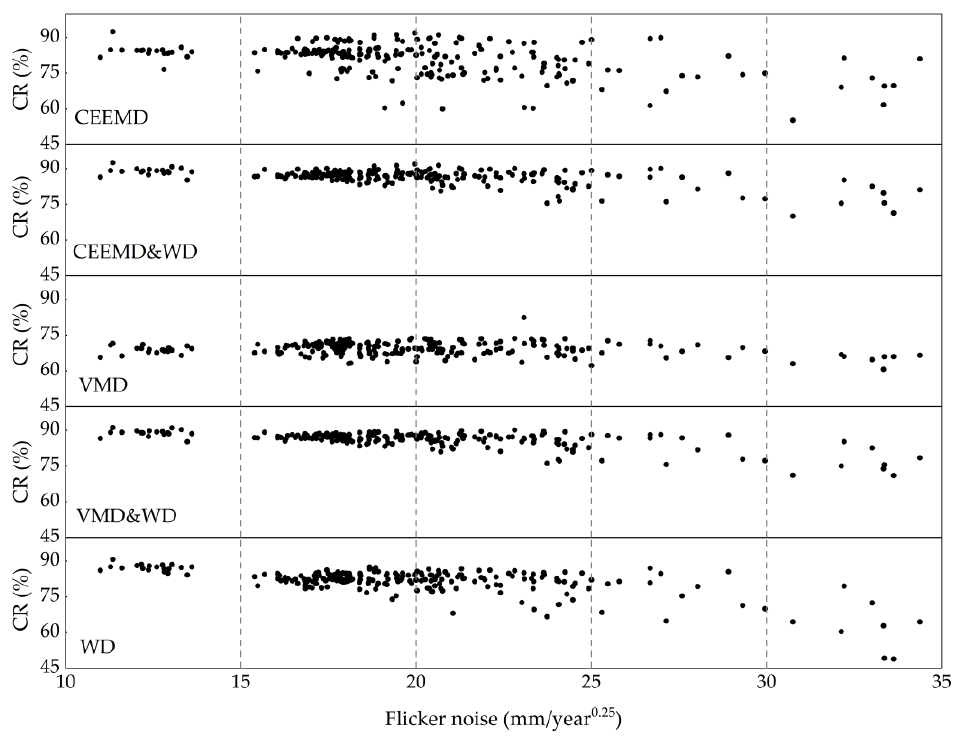
Figure 6. The CRs of flicker noise for different methods. Mean and std represent the average and standard deviation of CRs for each group, respectively. (Unit: %).